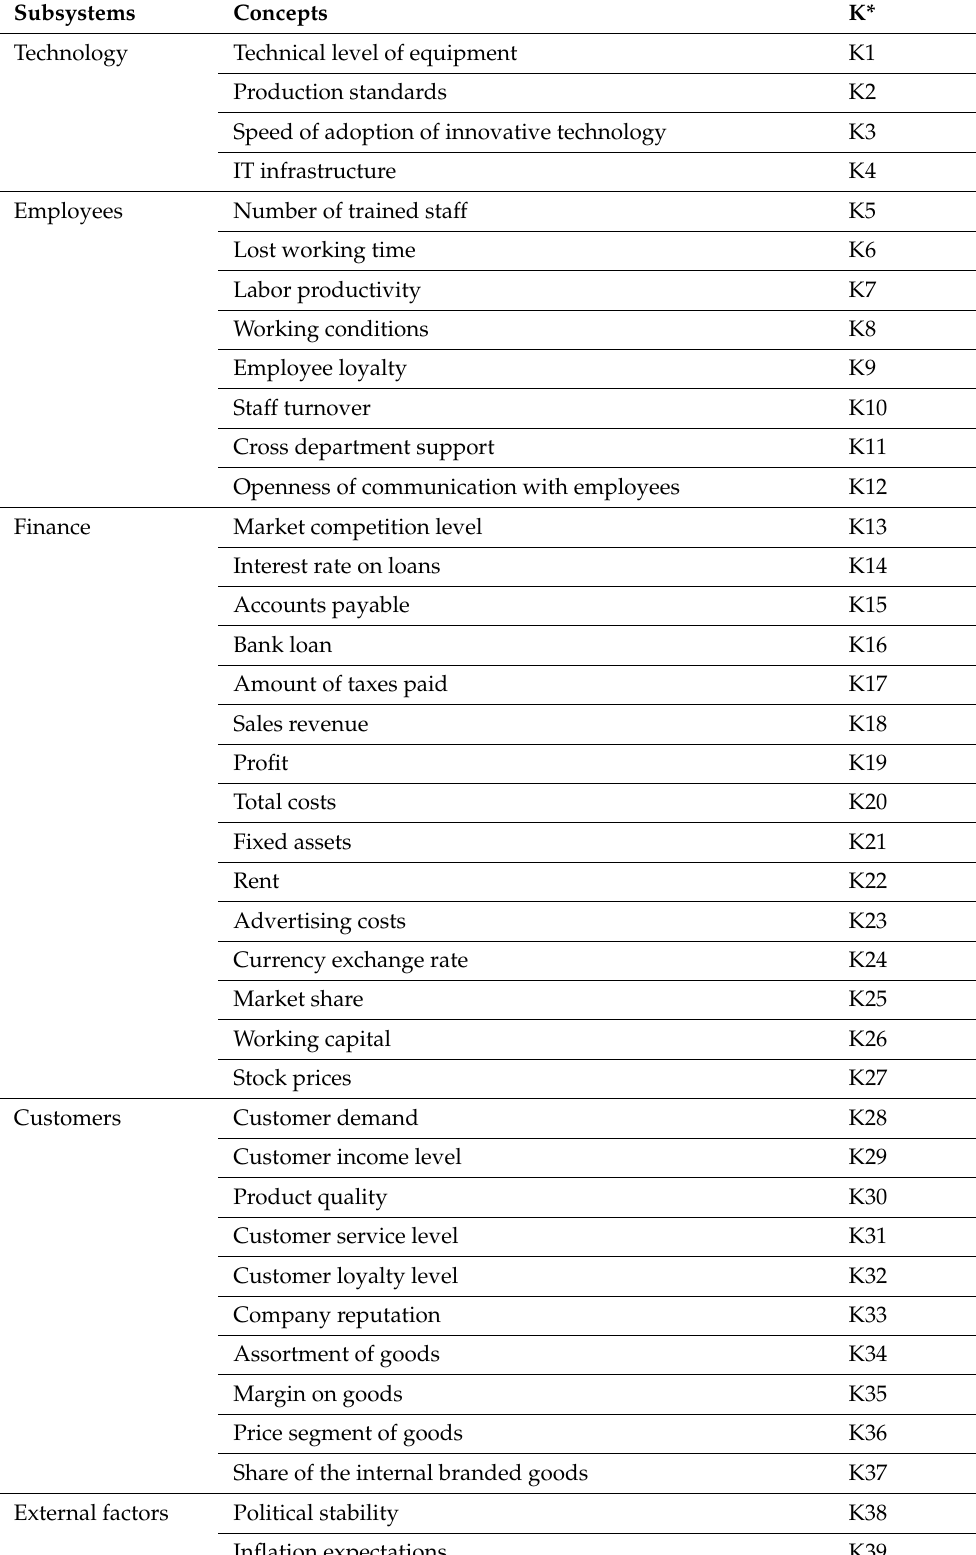
Table 3. Concepts and subsystems defined for the retail FCM. The K* column denotes concept